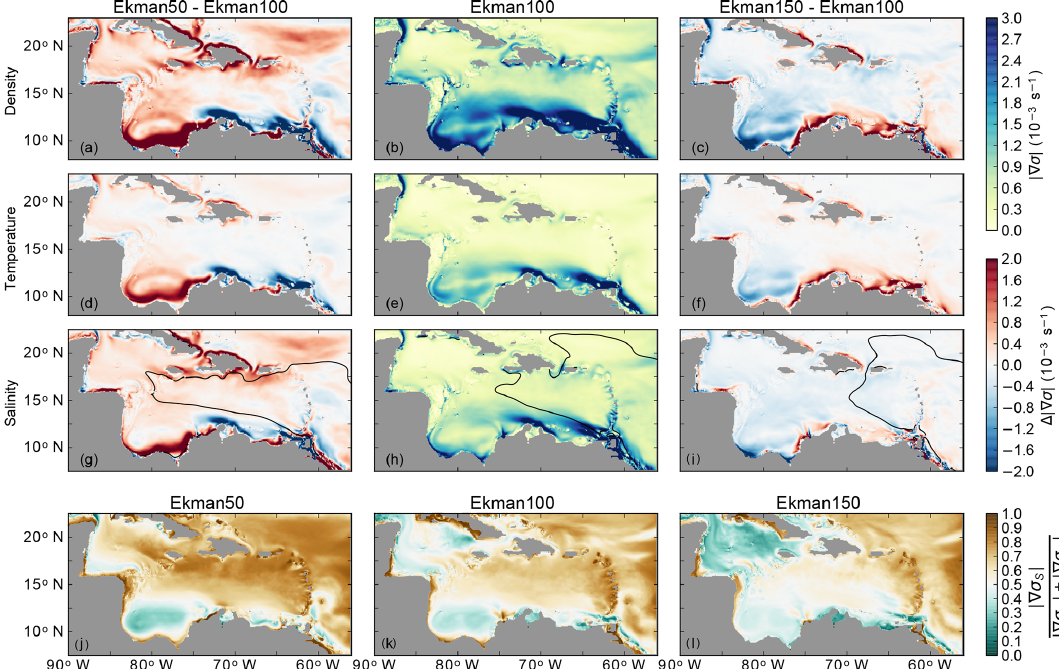
Figure 14. (a–c) Average strength of the horizontal density gradients ( |∇ σ | ) in Ekman50, Ekman100, and Ekman150 (see Sect. 2). The middle column shows the magnitude of the density gradients in Ekman100. The left and right columns show the difference between Ekman50 and Ekman100 and between Ekman150 and Ekman100, respectively. Red indicates an increase in the horizontal density gradient. (d–f) The average strength of the horizontal density gradients due to temperature variations ( |∇ σ T | ). (g–i) The average strength of horizontal density gradients due to salinity variations ( |∇ σ S | ). The solid black line indicates where S = 35 . 5psu. (j–l) The relative magnitude of density |∇ σ S | gradients due to salinity compared to density gradients due to temperature ( |∇ σ T |+|∇ σ S | ). All properties are averaged over 20 years and over the upper 50m of the water